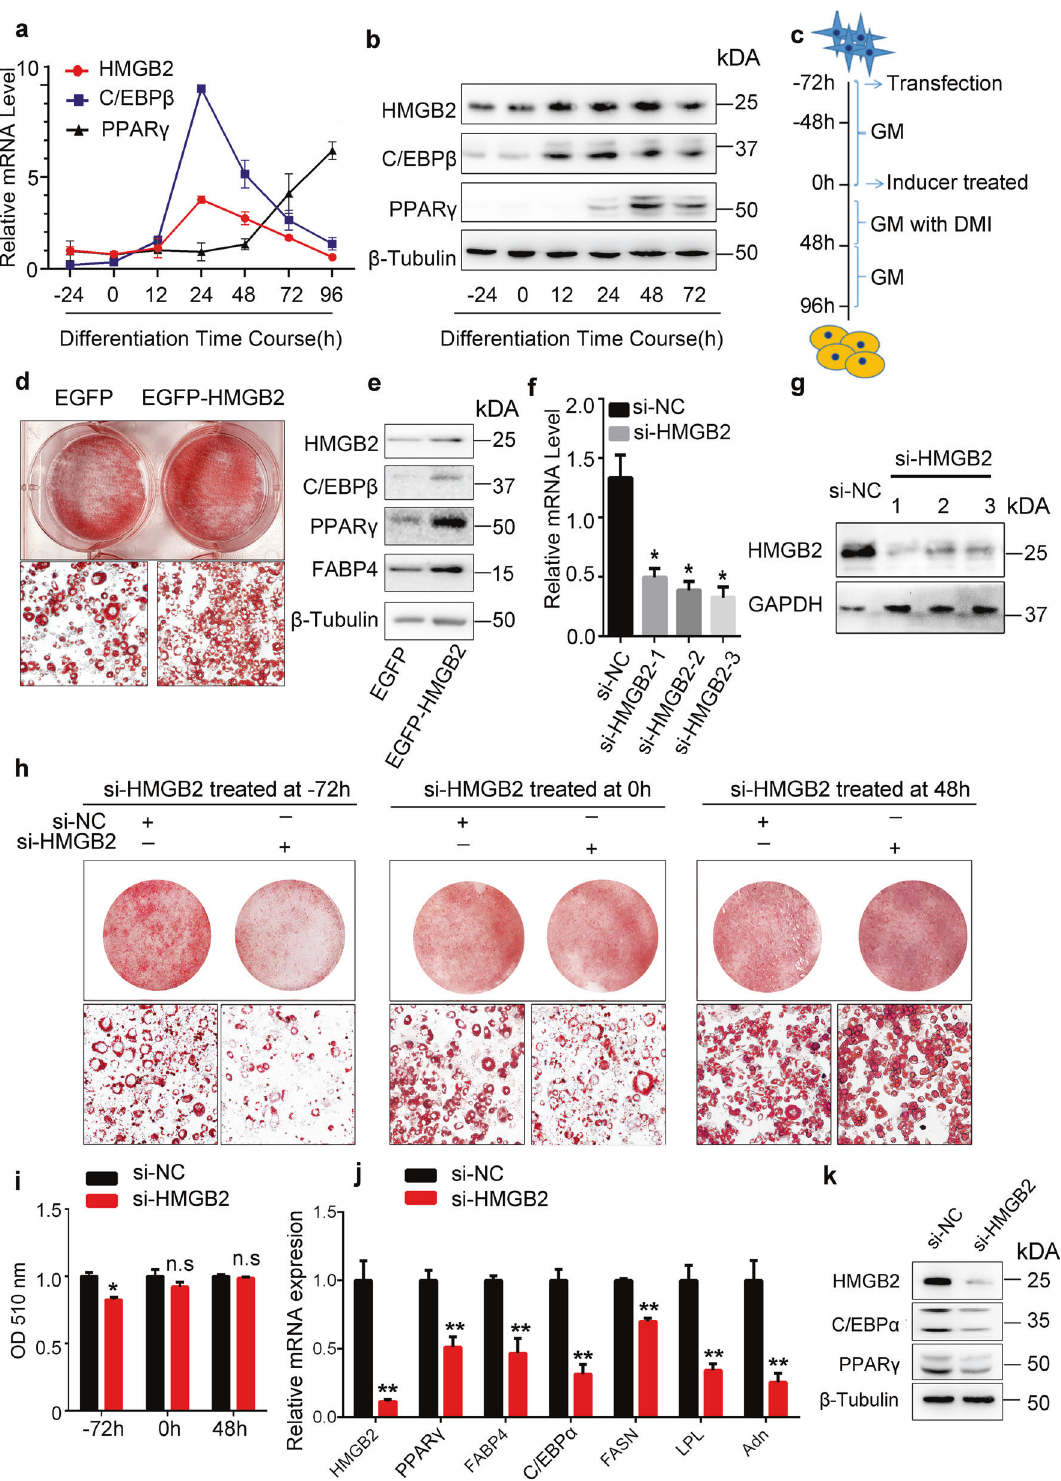
Fig. 1 HMGB2 is required for adipogenesis. a qPCR for mRNA of HMGB2, C/EBP β , and PPAR γ during 3T3-L1 cells differentiation. b Western blot analysis of protein levels of HMGB2, C/EBP β , and PPAR γ . c Schema of si-HMGB2 or EGFP-HMGB2 plasmid treatment during adipogenic induction. d Oil Red-O staining of cells treated with EGFP-HMGB2 plasmid. e Western blot analysis of EGFP-HMGB2 plasmid in 3T3-L1 cells. f , g Knockdown ef fi ciency of three si-HMGB2 examined by qPCR and western bot. h Effect of siRNA transfection at different time points on adipogenesis, as determined by Oil Red-O staining. i Statistical data of Oil Red-O by OD measurements. j qPCR for mRNA of HMGB2 and adipogenic genes. k Western blot analysis for HMGB2, C/EBP α , and PPAR γ . Data represent three biological replicates each with three technical replicates. ( f , j : n = 3; data presented in graphs represent mean s.e.m. * P < 0.05; ** P < 0.01, Students ’ t test. d , e , h : cells were harvested and stained at day 10, n = 3).